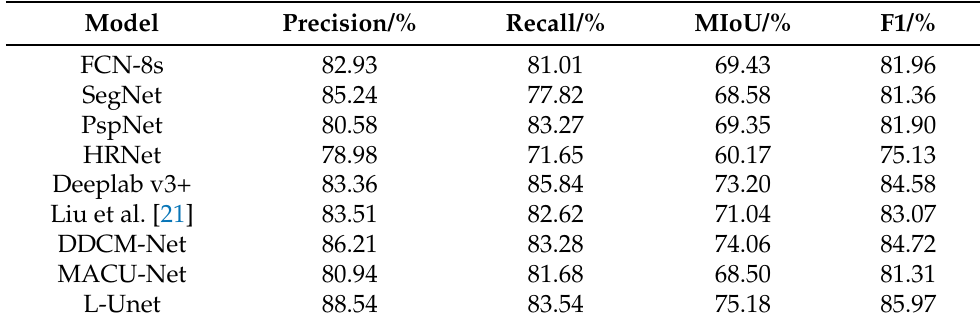
Figure 7. Comparison of the results of models U-Net, U-Net+MFF, U-Net+MFF+ResNet and L-Unet for the four metrics precision, recall, MIoU and F1. Table 2. Comparison of the performance of different